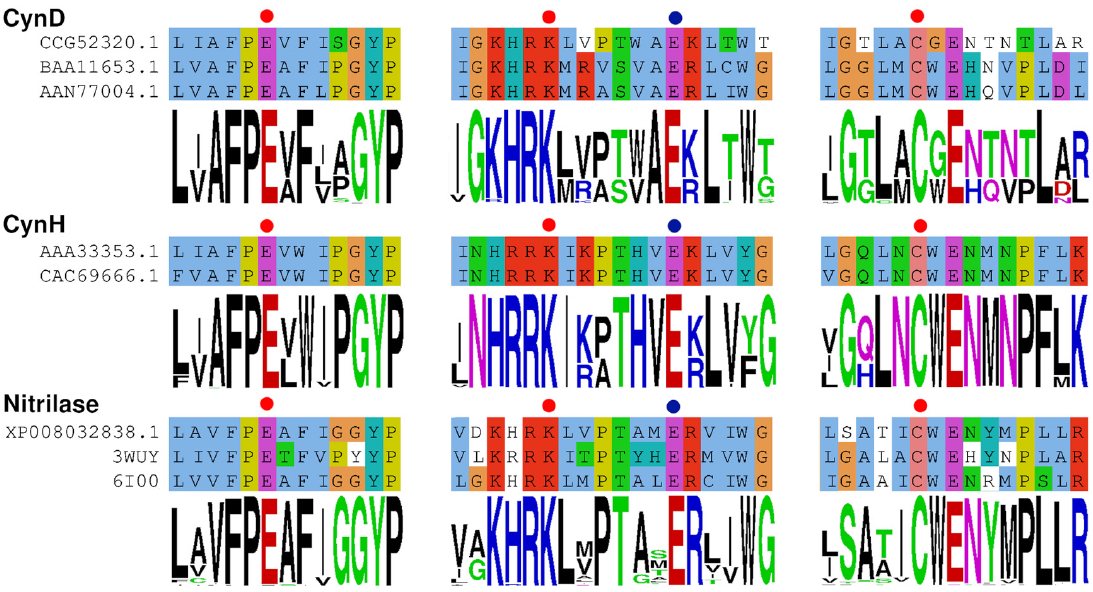
Figure 3. Sequence conservation diagrams of selected regions in cyanide dihydratases (CynDs) from Flavobacterium indicum (CCG52320.1), Stutzerimonas stutzeri (BAA11653.1) and Bacillus pumilus (AAN77004.1), cyanide hydratases (CynHs) from Microdochium sorghi (AAA33353.1) and Fusarium solani (CAC69666.1), and nitrilases (not utilizing HCN as substrate) from Trametes versicolor (XP_008032838.1), Synechocystis sp. (3wuy), and Arabidopsis thaliana (pdb 6i00). Red dots mark active site residues. Blue dots mark the second Glu of the catalytic tetrad. The alignment was constructed using CLUSTAL Omega. The diagrams were constructed with WebLogo (http://weblogo.berkeley.edu/logo.cgi). Active site amino acids were identified based on the previous study [1].